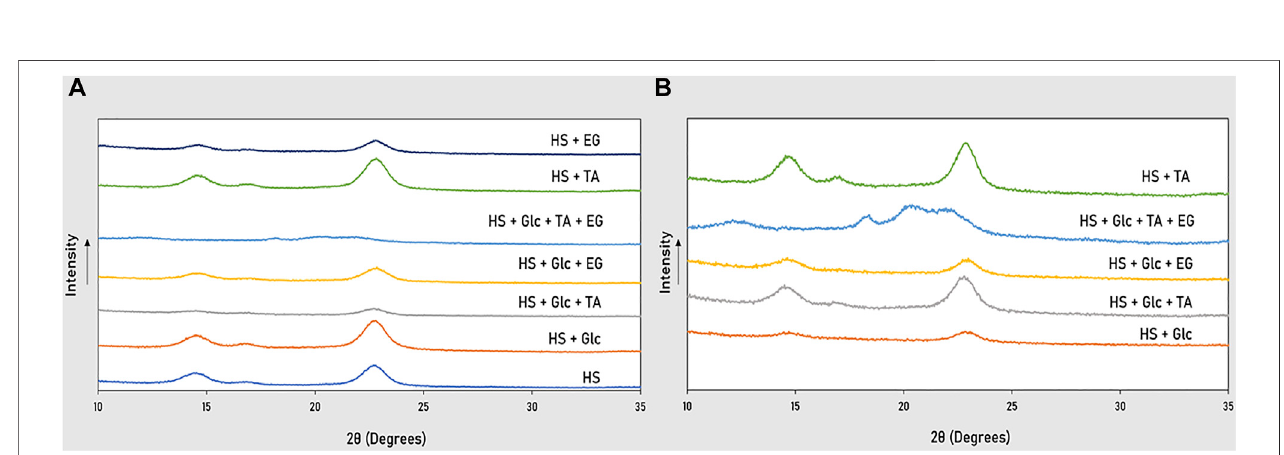
FIGURE 5 | XRD diffractograms of BC grown in glucose, TA, and EG by K. xylinus DSM 2004 (A) and DSM 46604 (B) .